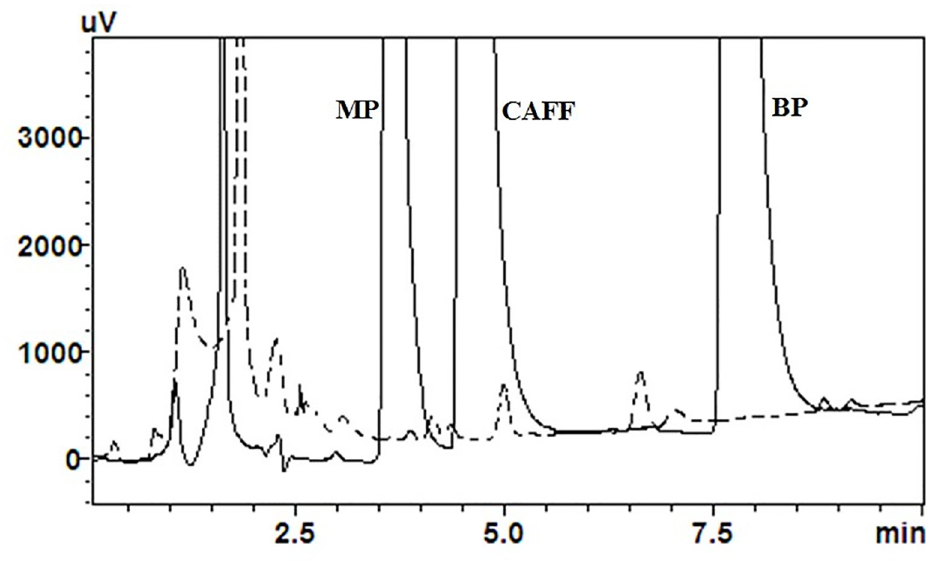
Fig 5. Comparison between the chromatogram for the mixture of analytes (continuous line) and that of the matrix (dotted line). The concentration of the mixture is 25 μ g/mL with respect to each analyte.